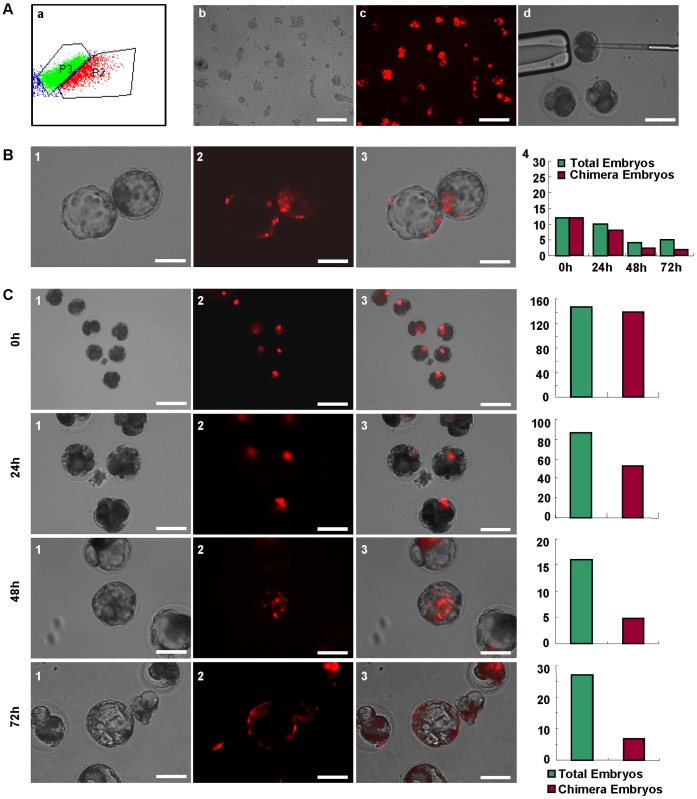
The piPS cells were used to generate chimera blastocyst in vitro.A, The PS24 cell transfected with piggyBac transposon PB[Act-RFP]DS was sorted by flow cytometer (1), and cells with RFP was fractionated in the portion 2 (P2). The PS24-RFP cells were cultured on MEF feeder (2), and showed the robust red fluorescence (3). The PS24-RFP cells were injected into pre-compacted porcine embryos through microinjection (4). Scale bars, 200 µm. B, A hatched blastocyst with the piPS cells located in both inner cell mass and trophoblast (1–3). (4) The number of chimera embryos were counted and plotted in the right panel along with the different time points, including 0 hour (0 h), 24 hours (24 h), 48 hours (48 h) and 72 hours (72 h), respectively. Scale bars, 100 µm. C, Five to ten PS24-RFP cells were delivered into pre-compacted parthenogenetic embryos by the microinjection. The chimera embryos were monitored at 0 h, 24 h, 48 h and 72 h, respectively. 1, bright field; 2, fluorescence; 3, merge. The number of total and chimera embryos was counted and plotted in the right panel. Scale bars, 100 µm in 24 h, 48 h and 72 h, and 200 µm in 0 h.